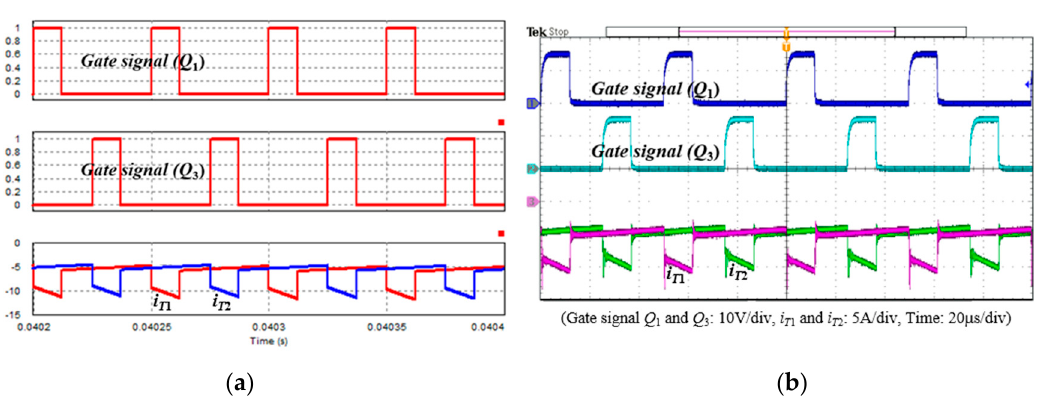
Figure 21. Waveforms of the switching gate signals and the primary-side currents of the coupled inductor in the dual-energy in series discharge mode with D d = 0.25: ( a ) simulated and ( b ) experimental.